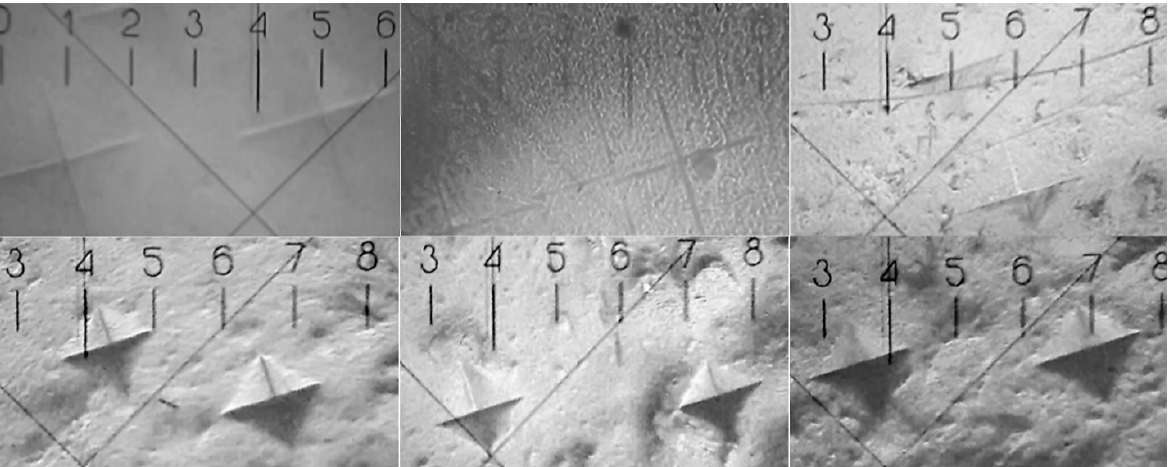
Figure 1. Determination of the microhardness of samples containing different proportions of nano- cHAp and adhesive from the indentation made by the diamond pyramid in the samples. Magnifi- cation ×130.